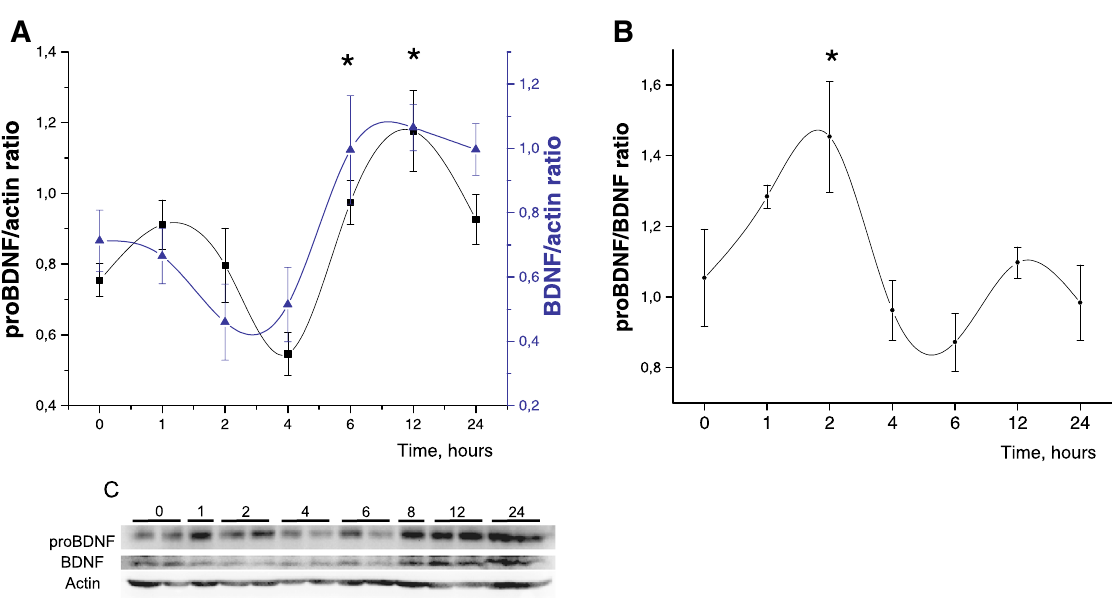
Figure 2. Timeline changes of matBDNF and proBDNF protein level in the HPC after DEX injection to P2 rat pups. ( A ) proBDNF and mature BDNF protein expression level changes ( B ) proBDNF/BDNF ratio changes. ONE WAY ANOVA, * p < 0.05 compared to the control group. Data are presented as M ± SE ( C ) representative western blot image. (original western blot images are accompanied in Supplementary treated group Fig. 3d. This fluorescence signal corresponds to basal TH level. After DEX administration to P2 rat pups we observed elevation of TH activity 51 and expression 52 in the brainstem. Depressive like behaviour after neonatal dexamethasone administration at P2 and chronic mild unpredictable stress in adolescence. To evaluate changes in depressive like behaviour caused by